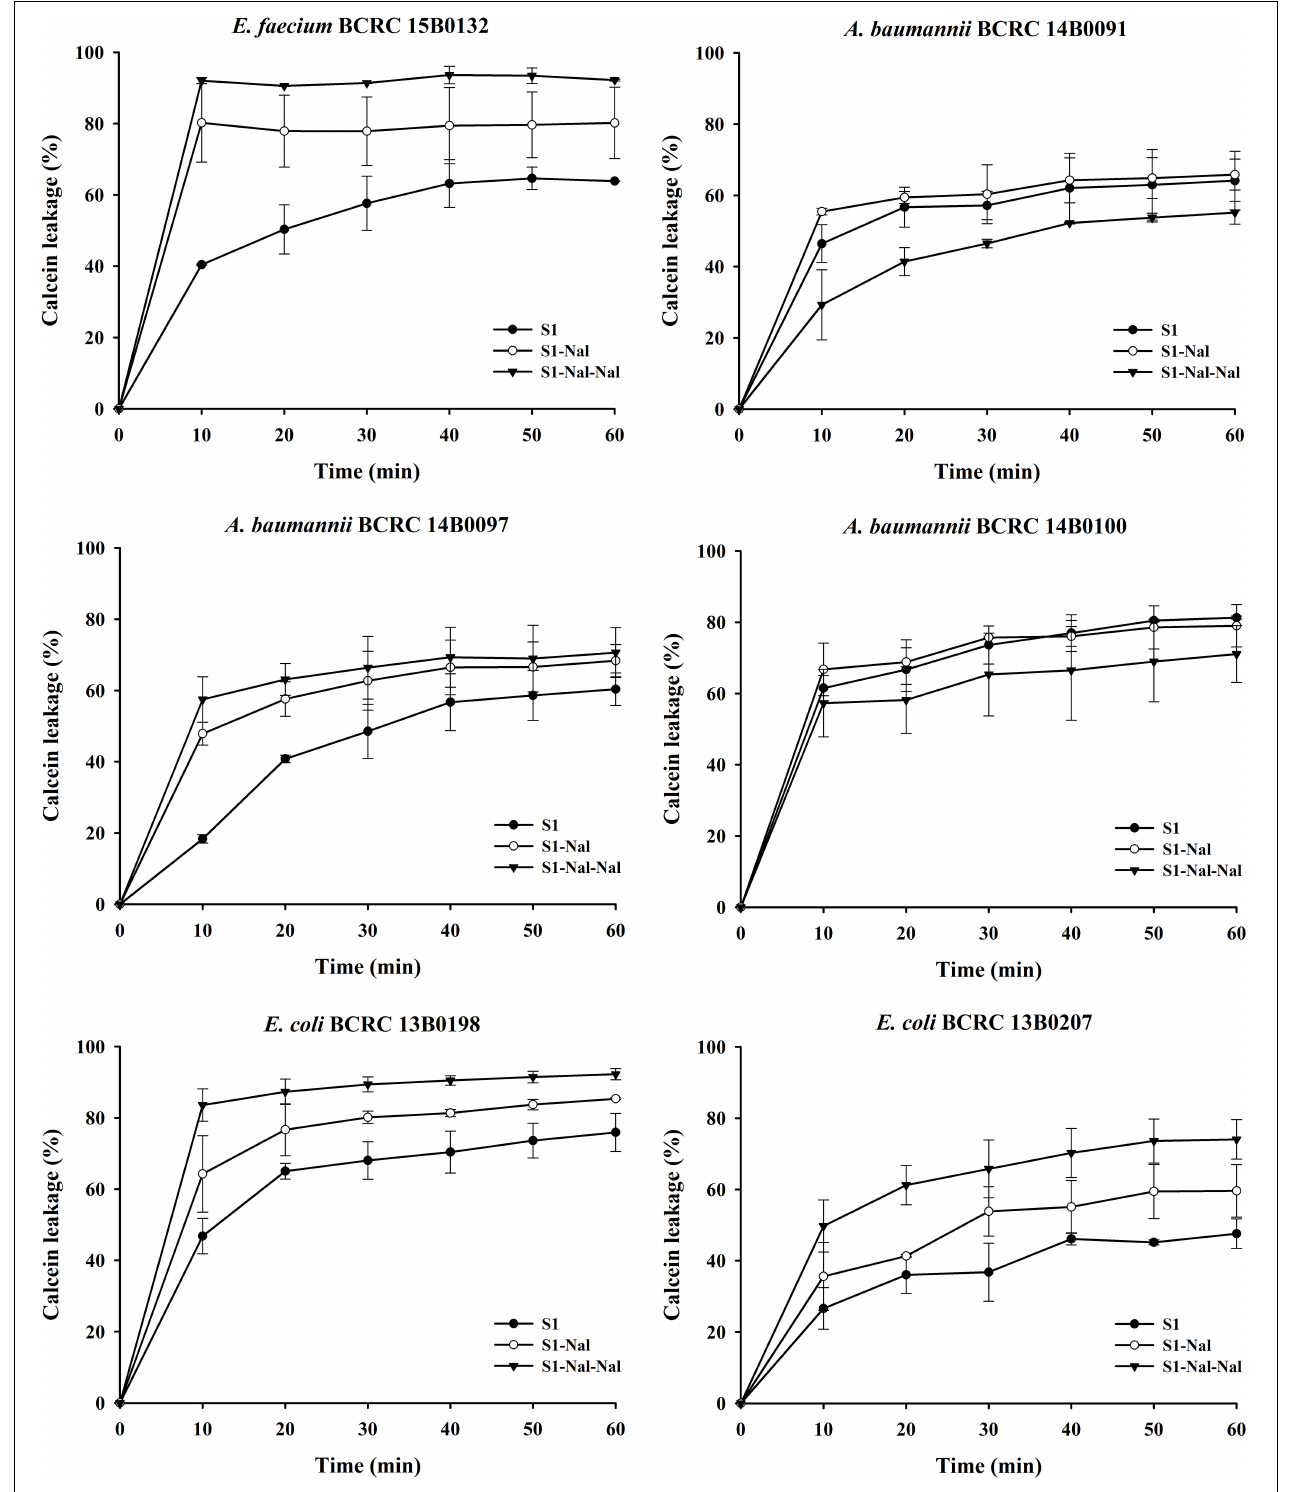
FIGURE 1 | The membrane permeabilization of Enterococcus faecium BCRC 15B0132, Acinetobacter baumannii BCRC 14B0091, A. baumannii BCRC 14B0097, A. baumannii BCRC 14B0100, Escherichia coli BCRC 13B0198, and E. coli BCRC 13B0207, by S1, S1-Nal, and S1-Nal-Nal for 60 min exposure. Calcein-AM loaded cells (10 7 CFU/ml) were resuspended by PBS, and the aliquots of 100 µ l were added into a sterile black-wall 96-well plate, then treated with 0.5 × MIC of peptides in each well and measured the calcein leakage immediately. Each time point for the peptides was repeated three times independently.